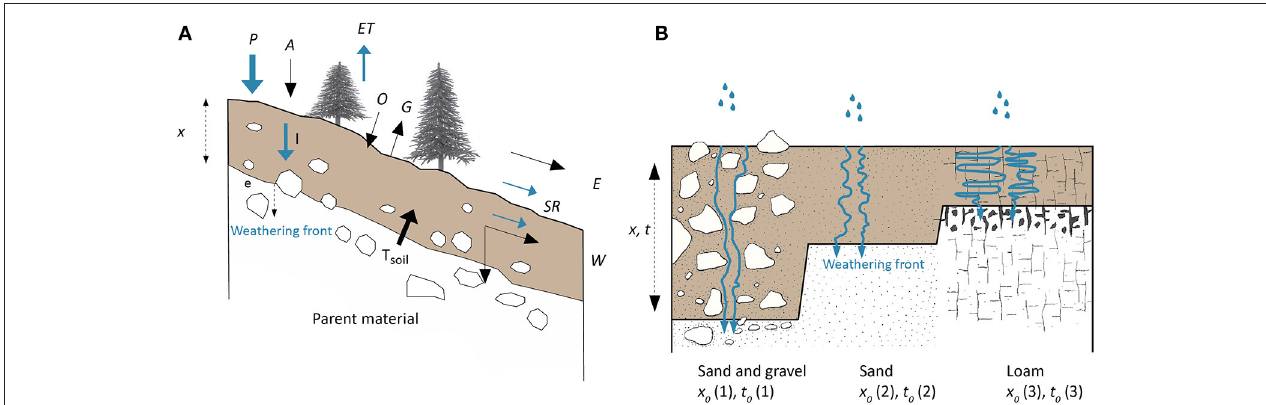
FIGURE 1 | Schematic overview of the applied concept. (A) The black arrows show the mass fluxes into and out of a soil with T Soil = the transformation of the parent material or rock into soil, A = atmospheric deposition, O = net organic matter input, G = organic matter decay, E = Erosion and W = chemical weathering (solute output). Water fluxes into and out of the soil are given by the blue arrows with P = precipitation, ET = evapotranspiration, SR = surface and subsurface runoff, I = infiltration. The weathering front e is intimately linked to these water fluxes. (B) Soil depth ( x ) as a function of the median granulometry ( x 0 as fundamental length scale) of the soil (scheme modified after Birkeland, 1984). Time constraints are given by the fundamental length scale, x 0 , and the corresponding time scale, t 0 , and x and the related time scale t . The ratio of x 0 / t 0 = v 0 , is assumed to represent the pore-scale fluid flow rate (see Equation 2).